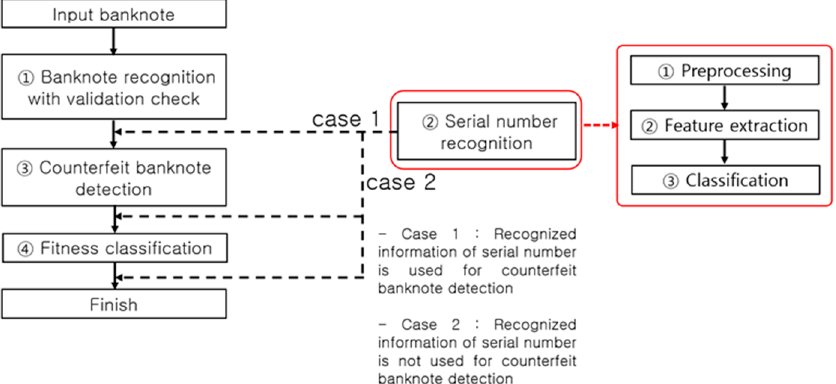
Figure 17. Serial number recognition process flow.